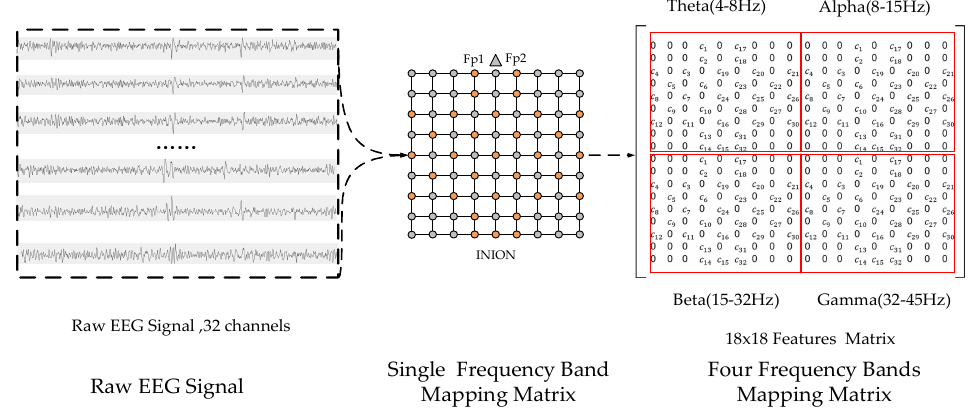
Figure 4. The mapping process of multiband feature matrix according to the raw electroencephalograph (EEG) signals of 32 channels.